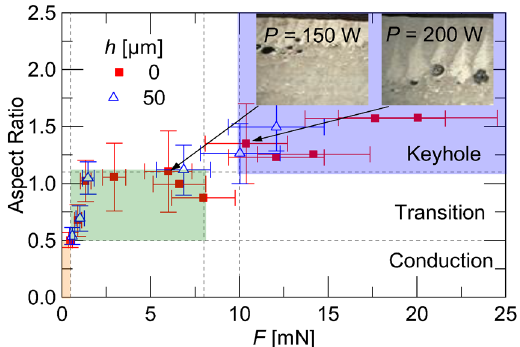
Figure 10. Melt pool aspect ratio as function of recoil force with horizontal lines indicating dominant melting modes and vertical lines representing recoil force magnitudes at melting mode boundaries with insets showing micrographs that were collected at V = 120 mm/s and PRF = 2